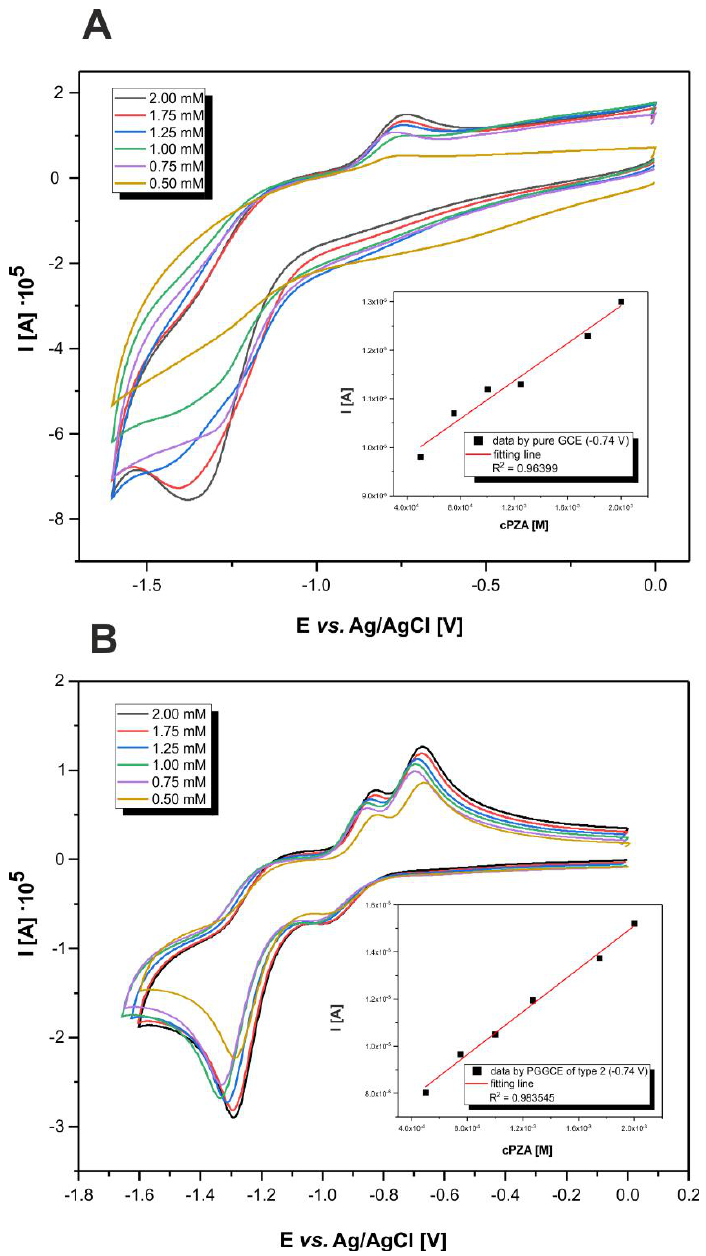
Figure 7. Comparison of voltammograms (CV) and linearities for PZA stoichiometric detections using pure GCE ( A ) and modified PGGCE type 2 ( B ).